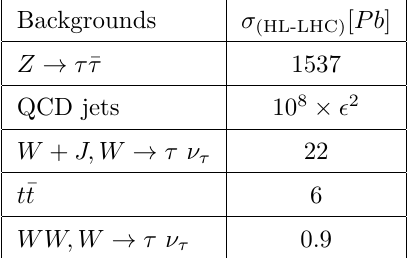
Table 1 . Dominant background processes considered in our analysis and their total cross sections. The samples have been produced with the following cuts: P efficiency of the QCD jets to be mistagged as tau jet is taken from the CMS paper [63] and we use the fake rate (cid:15) = 5 × 10 − 3 from ref.